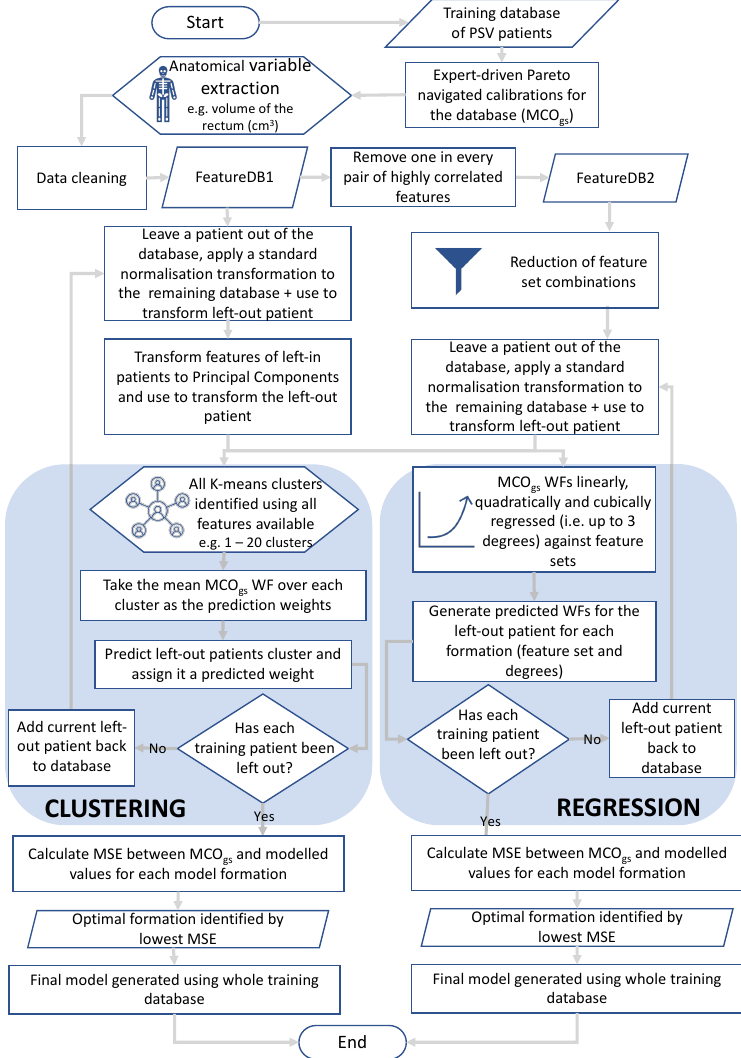
Figure 2. Flowchart illustrating the ML